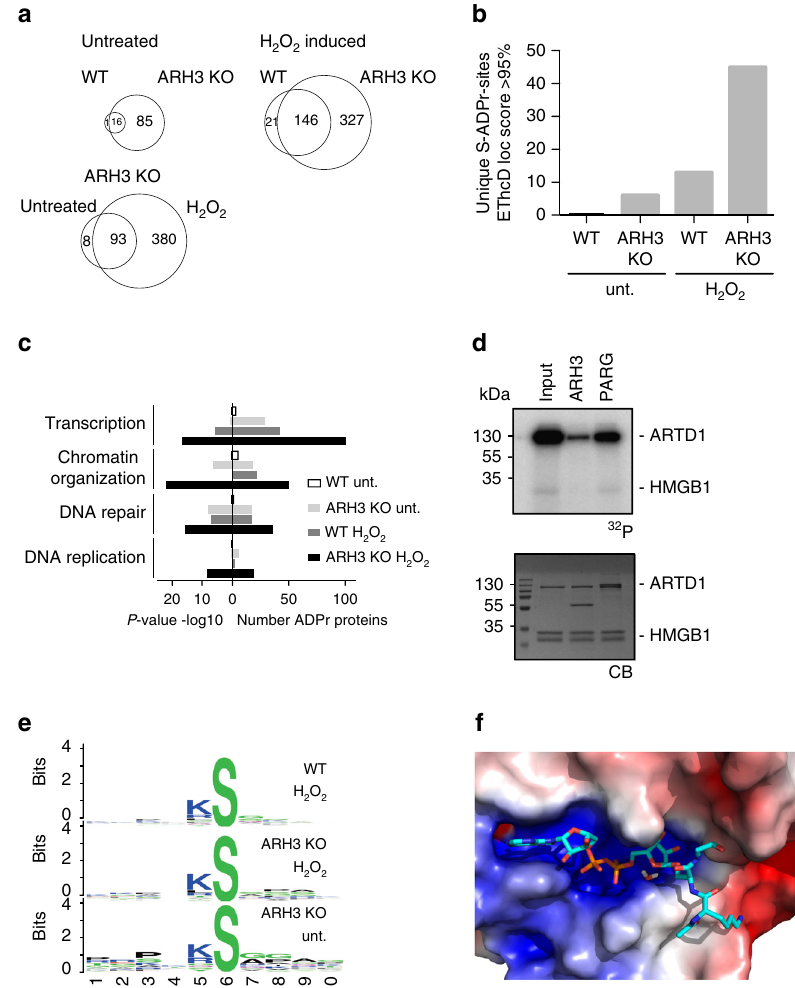
Fig. 3 ARH3 regulates basal and hydrogen peroxide-induced serine ADP-ribosylation in vivo. a Venn diagrams of unique ADP-ribosylated peptides of wild type (WT) and ARH3 KO MEF cells under basal and H 2 O 2 -treated conditions. b Unique ADP-ribosylation sites detected by EThcD fragmentation in the different samples. c Gene ontology analysis of the identi fi ed ADPr-modi fi ed proteins using the PANTHER database. Shown on the left are the P -values and on the right the number of identi fi ed and annotated ADP-ribosylated proteins. d Validation of mono-ARH activity of ARH3 on the nuclear protein HMGB1. Recombinant HMGB1 was in vitro ADP-ribosylated using recombinant ARTD1 in the presence of 32 P-labeled NAD + . Equal fractions were left untreated (Input) or were treated with PARG or ARH3. Above: radioactivity exposure, below: Coomassie Blue-stained poly-acrylamide gel. e Motif searches for ADP-ribosylated peptides with a mascot site localization score > 80% in MEF cells using Weblogo. f Energy minimized binding mode of an acetyl-KSG peptide with ADPr-Ser modi fi cation. The surface of ARH3 (including the binding-site magnesium ions) is colored according to electrostatic potential (on a scale of − 5 to 5 kT/e). The positively charged amino group of the K side chain and the backbone amide groups point toward the region of the surface